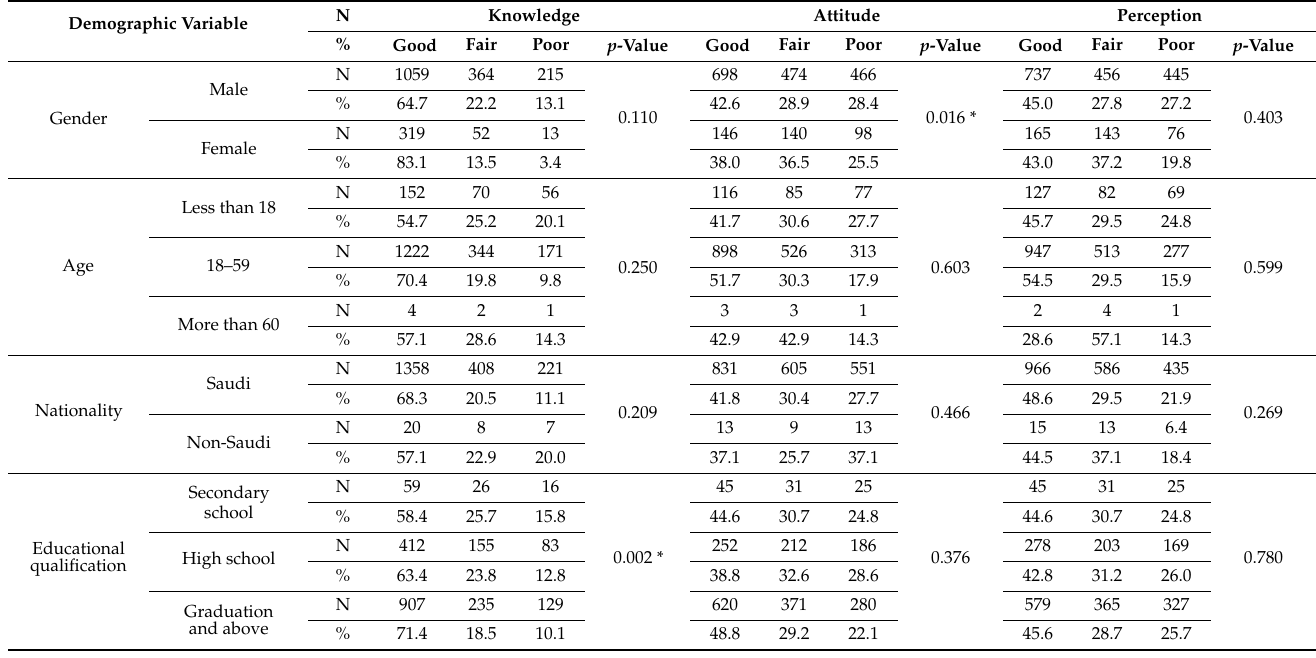
Table 6. Categorization of participants’ scores on KAP domains.